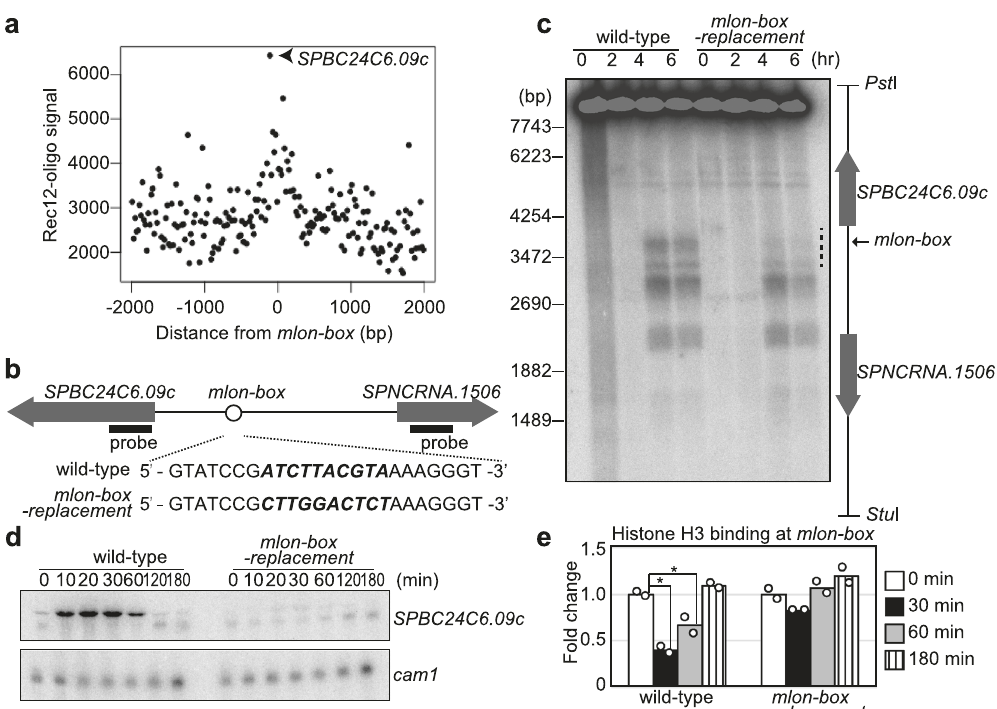
Fig. 5 DSB formation at the natural meiotic recombination hotspot in the SPBC24C6.09c upstream region is mediated by mlon-box -dependent intergenic transcription. a Relationship between mlon-box sites and meiotic DSB distribution (Rec12-oligos). The X axis indicates the distance from the nearest mlon-box , and the Y axis indicates copy numbers of the Rec12-oligos-signal. The strongest plot (arrowhead) represents the meiotic recombination hotspot in the SPBC24C6.09c upstream region. b Schematic representation of the mlon-box (open circle) in the intergenic region between SPBC24C6.09c and SPNCRNA.1506 . The entire mlon-box sequence comprising 10 nucleotides was replaced with a 10 nucleotide sequence from act1 ORF in mlon-box- replacement cells (bold italic). Location of probes for northern blot was indicated by bold bar. c Detection of meiotic DSBs in the intergenic region between SPBC24C6.09c and SPNCRNA.1506 . Indicated cells were cultured and analyzed, as described in Fig. 2b. The dotted line indicates DSB sites around the mlon- box . d Northern analysis to detect the SPBC24C6.09c transcript in wild-type and mlon-box-replacement cells. The left probe indicated in Fig. 4b was used. Indicated cells were cultured to induce meiosis, as described in Fig. 2b. The cam1 transcript is shown as a loading control. e , ChIP analysis to examine histone H3 binding at the mlon-box in indicated cells. Cells were cultured to induce meiosis, as described in Fig. 2b. The relative increase in the ratio at the indicated time after the onset of meiosis is indicated. n = 2 biologically independent experiments. P -values were calculated using Student ’ s t -test: * P <